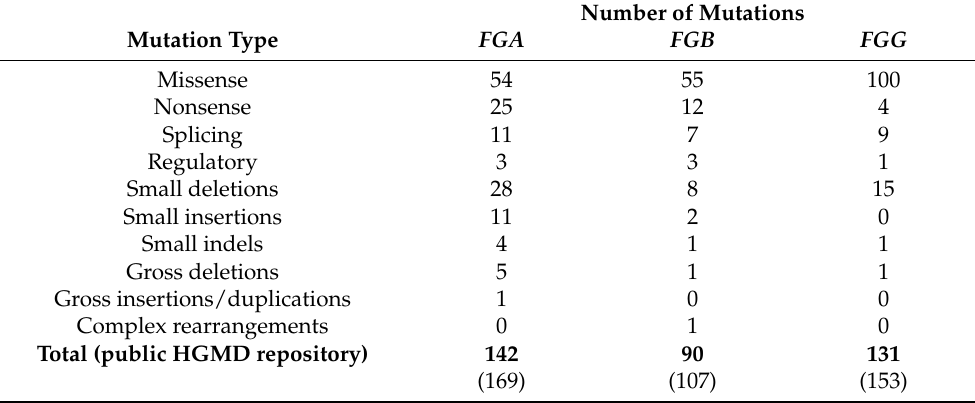
Table 3. Mutational spectra of congenital fibrinogen disorders in the FGA , FGB , and FGG genes.